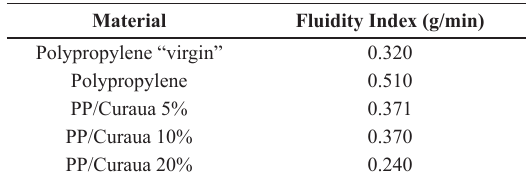
Table 1. Average values of the pellets submitted to the FI